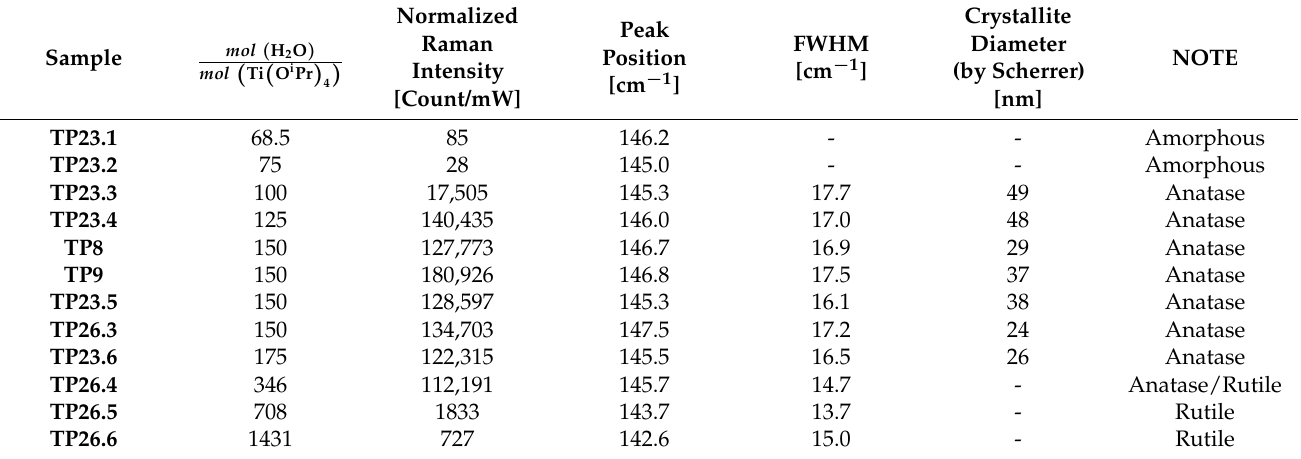
Table 2. Samples obtained with ethylene glycol synthesis: optical and morphological properties.